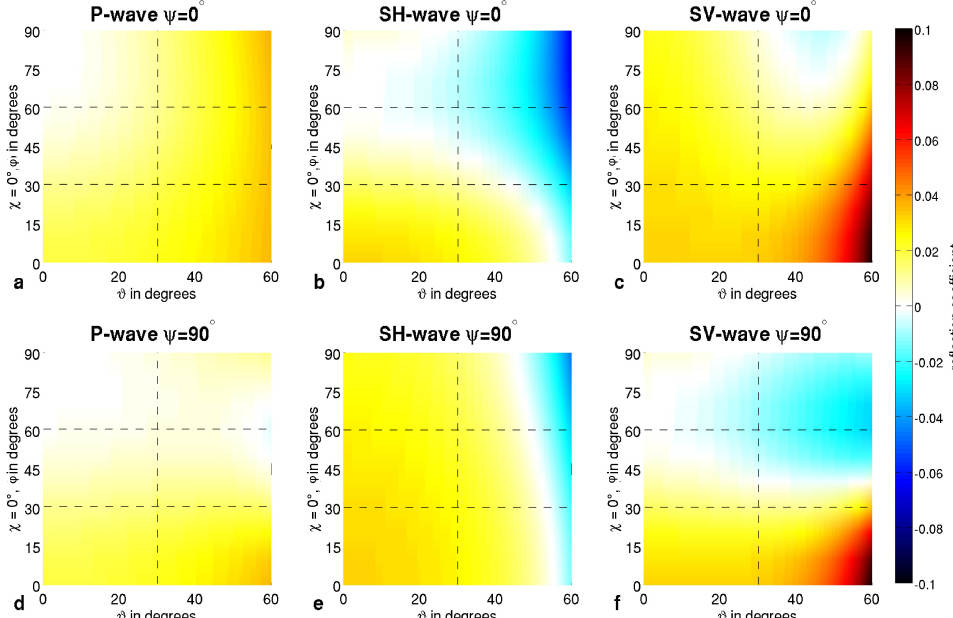
Figure 5. Reflection coefficients for the boundary between an isotropic (upper) layer and a partial girdle fabric (lower) layer with different opening angles ϕ ( χ = 0 ◦ ) of the girdle. The reflection coefficients are calculated with equations given in Sect. 4.3 for different incoming phase angles ϑ . The subfigures (a) , (b) and (c) show the reflection coefficients for a girdle orientation (lower layer) perpendicular to the travel path of the wave (HTI media) for PP, SHSH and SVSV reflection, respectively. The subfigures (d) , (e) and (f) show the reflection coefficients for a girdle orientation parallel to the travel path of the wave (azimuth ψ = 90 ◦ ) for PP, SHSH and SVSV reflection, respectively.